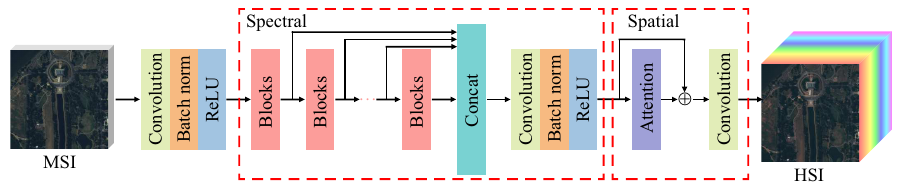
Figure 2. Architecture of the proposed SSRN. A spectral module and a spatial module are utilized to learn the pixel-wise spectral mapping between MSIs and HSIs. ⊕ represents the residual connection.